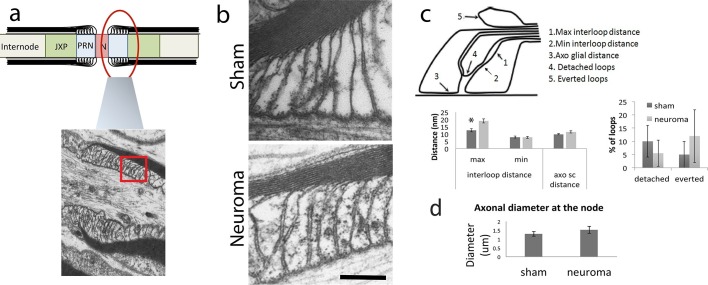
Ultrastructural anatomy of the node of Ranvier within the sciatic nerve following axotomy.We used electron microscopy to look at the ultrastructure anatomy of the node. (a) Shows a diagram of the node, paranode and juxtaparanode and a low magnification section of this area in a sham-operated nerve. The red box denotes the area that was used for quantification as seen in b. (b) High magnification views of the paranodal loops are shown in the sham and 21 days following axotomy (magnification 135 000x) (c) We quantified different aspects of the attachment of the Schwann cell paranodal loops to the axon. This is illustrated in right panel which denotes the different parameters measured: The maximal and minimal distance between interloops, the distance between the glia and the axon, the number of detached loops and the number of everted loops. We found a significant increase in the maximal distance between loops in the neuroma compared to sham nerves (one way ANOVA, p = 0.005). There were no significant differences in any of the other measurements. (d) We quantified the diameter of the axons at the site of the node and found no difference between the uninjured and injured axons. Scare bars: 200 nm.DOI:
http://dx.doi.org/10.7554/eLife.12661.00910.7554/eLife.12661.010Figure 4—source data 1.Source data for Figure 4.